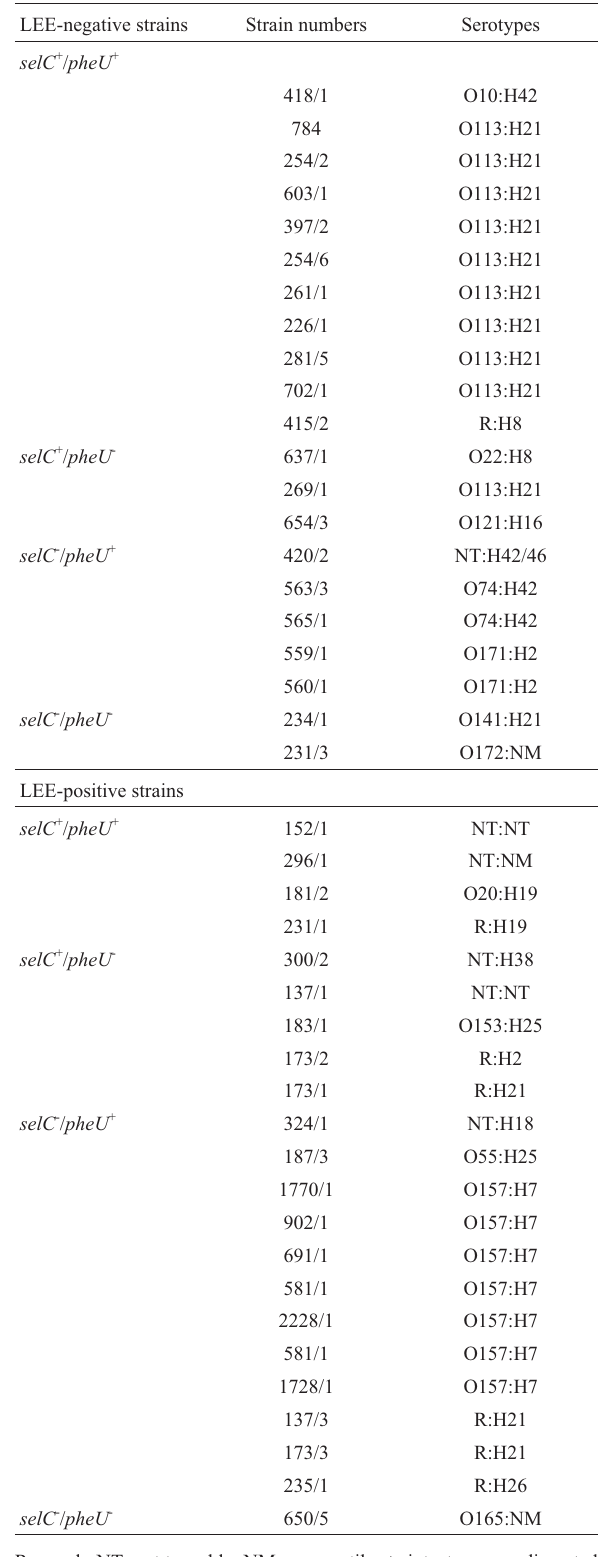
Table 1 - Characterization of selC and pheU genotypes and serotypes of 43 LEE- negative and positive strains. LEE-negative strains